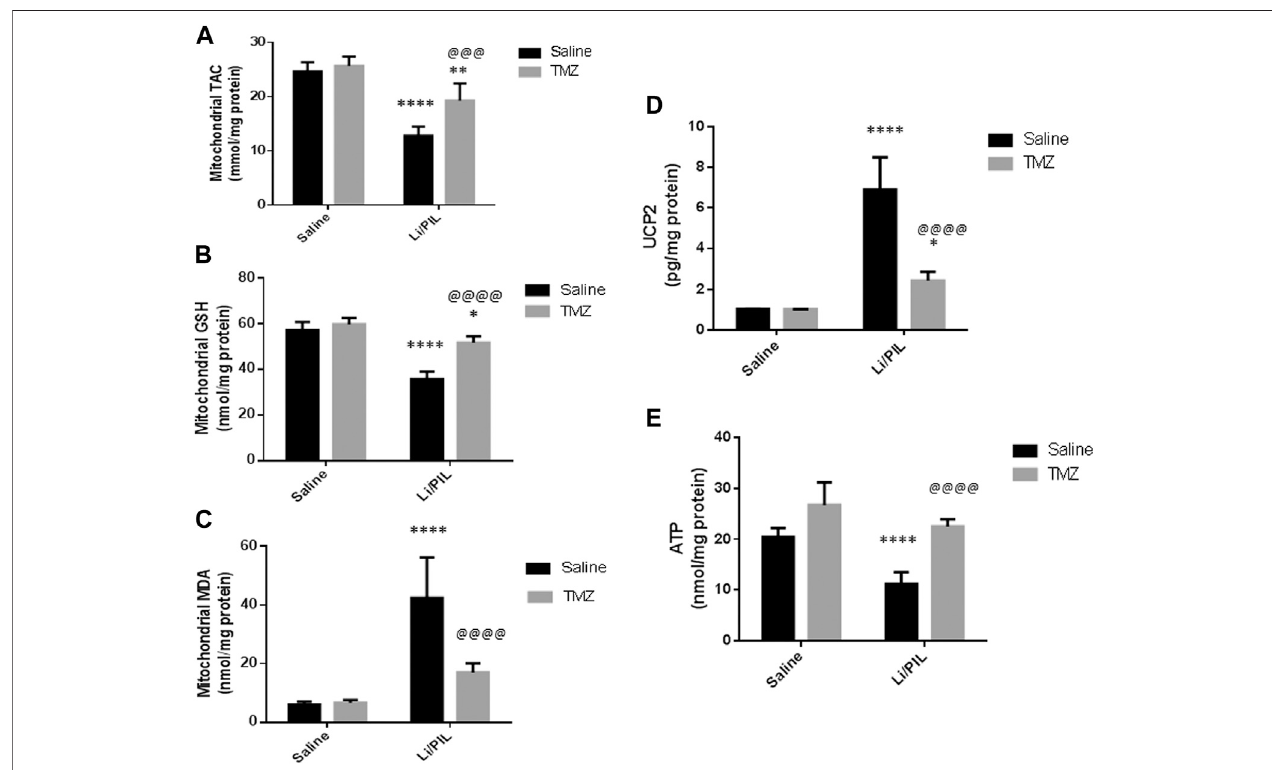
FIGURE 5 | EffectofTMZ on mitochondrial oxidative stress, mitochondrial uncoupling protein 2 (UCP2), and ATP production in the hippocampi ofrats with Li/PIL- induced seizures. (A) TAC, (B) reduced GSH contents, (C) MDA levels, (D) UCP2, (E) ATP. Values are expressed as mean of six animals ± SD. Two-way ANOVA followed by the Tukey – Kramer post-hoc test was used for statistical analyses of data. *Signi fi cantly different from the normal control group (Saline) at p < 0.05; **Signi fi cantly different from the normal control group (Saline) at p < 0.01; ****Signi fi cantly different from the normal control group at p < 0.0001; @@@ Signi fi cantly different from the Li/PIL control group at p < 0.001; @@@@ Signi fi cantly different from the Li/PIL control group at p <